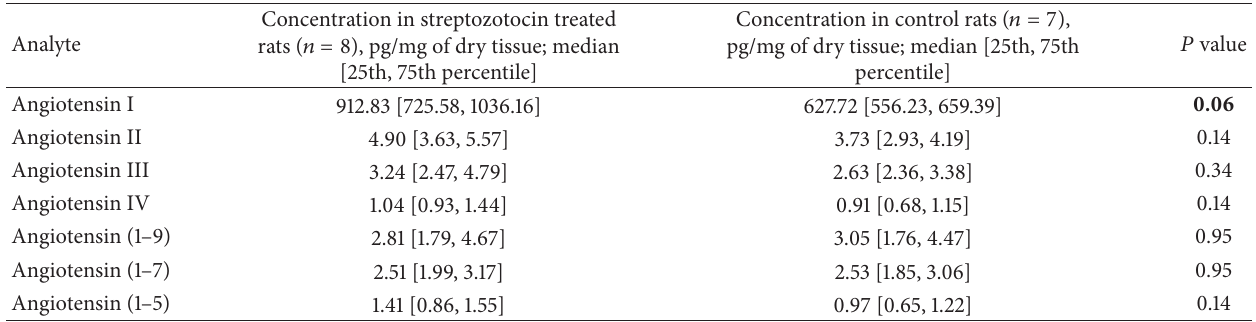
Table 3: Concentrations of the products of metabolism of exogenously added (to a final concentration of 1 𝜇 M) angiotensin I by the aorta fragments pretreated with thiorphan (final concentration 3 𝜇 M) from streptozotocin and saline treated animals (pg/mg of dry tissue; median [25th, 75th percentile]). 𝑃 values are from Kruskal-Wallis nonparametric